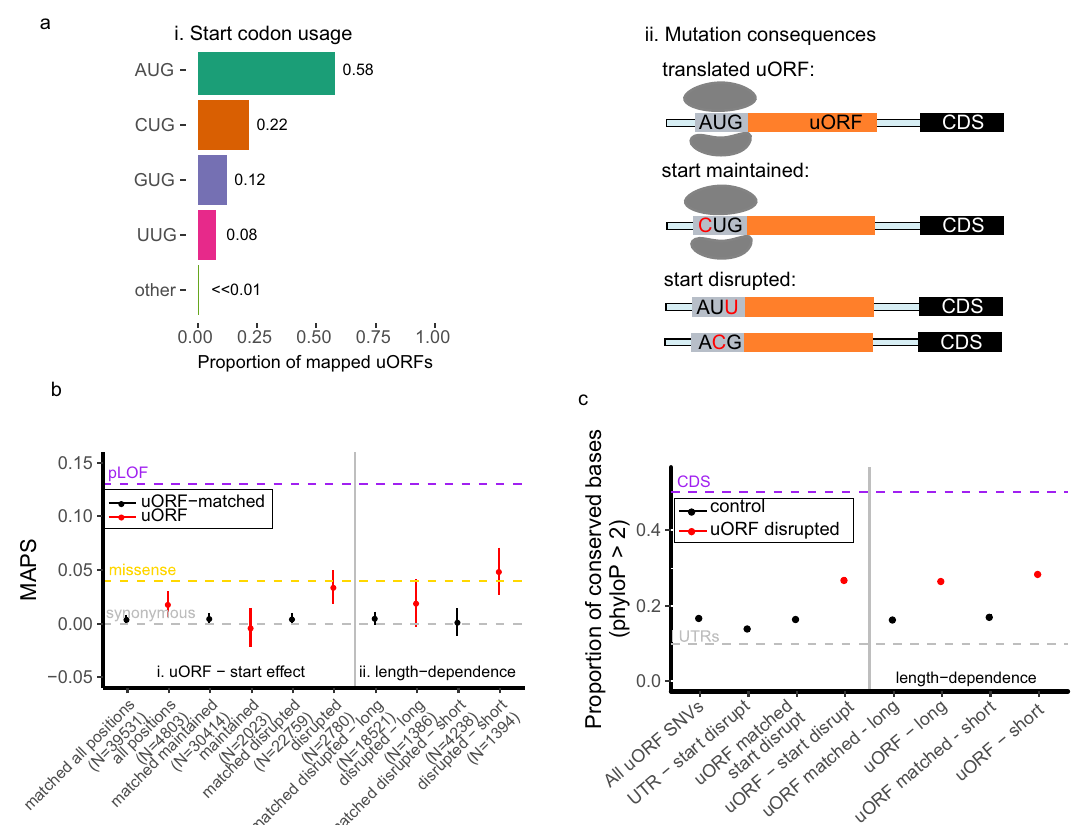
Fig. 3 Selective pressure to preserve uORF start codons. a (i) Distribution of start codon usage for experimentally mapped translated uORFs and (ii) possible consequences of variants affecting uORF start codons. b Points representing (i) MAPS scores for start-disrupting SNVs are compared to uORF variants matched by trinucleotide mutation context. (ii) Start-disrupting SNVs for short (<20 codons) uORFs are under stronger negative selection compared to start-disrupting variants for long ( ≥ 20 codons) uORFs. Error bars represent bootstrapped 90% con fi dence intervals. c Points representing proportion of conserved bases for possible start codon disrupting positions in uORFs compared to all uORF SNVs, UTR-matched start-disrupting positions, and uORF-matched start-disrupting positions in translated uORFs. Start-disrupting genomic positions of short uORFs are more strongly conserved by phyloP scores compared to matched start-disrupting positions within uORFs. Error bars represent bootstrapped 90% con fi dence